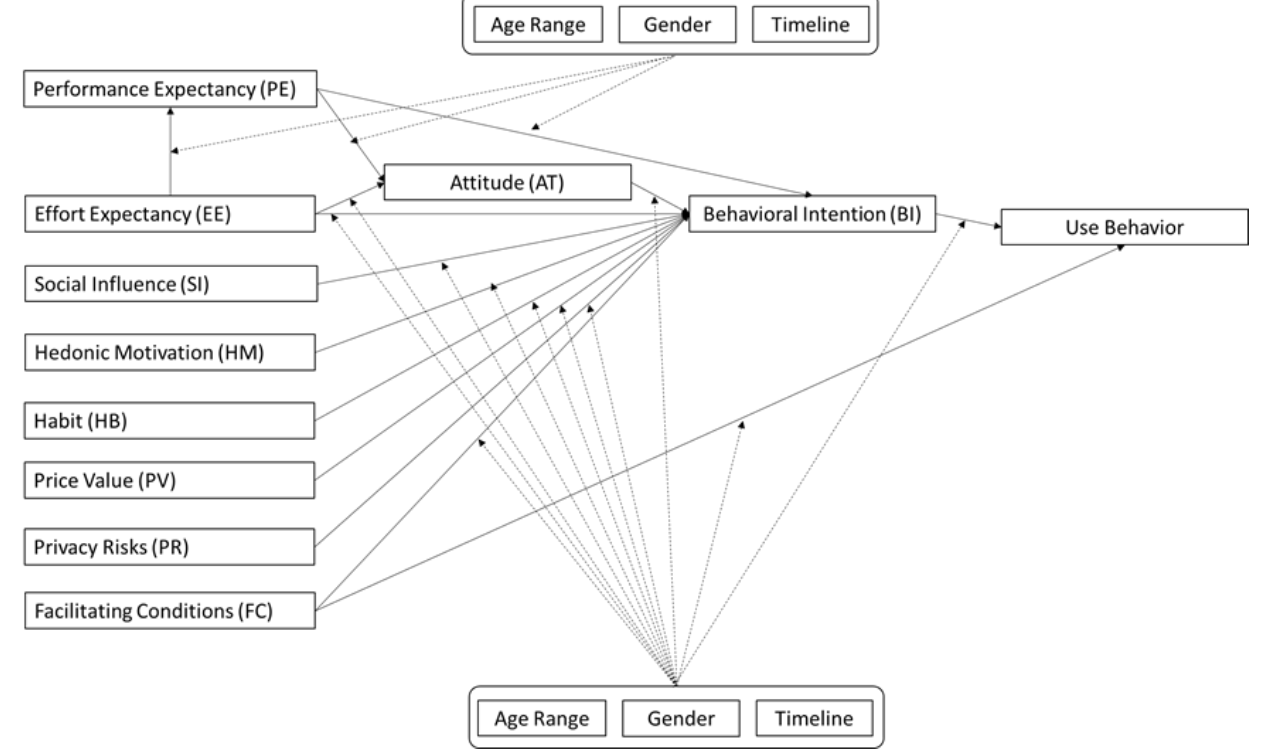
Figure 1. Proposition of the model based on the UTAUT2 used in the meta-analysis.